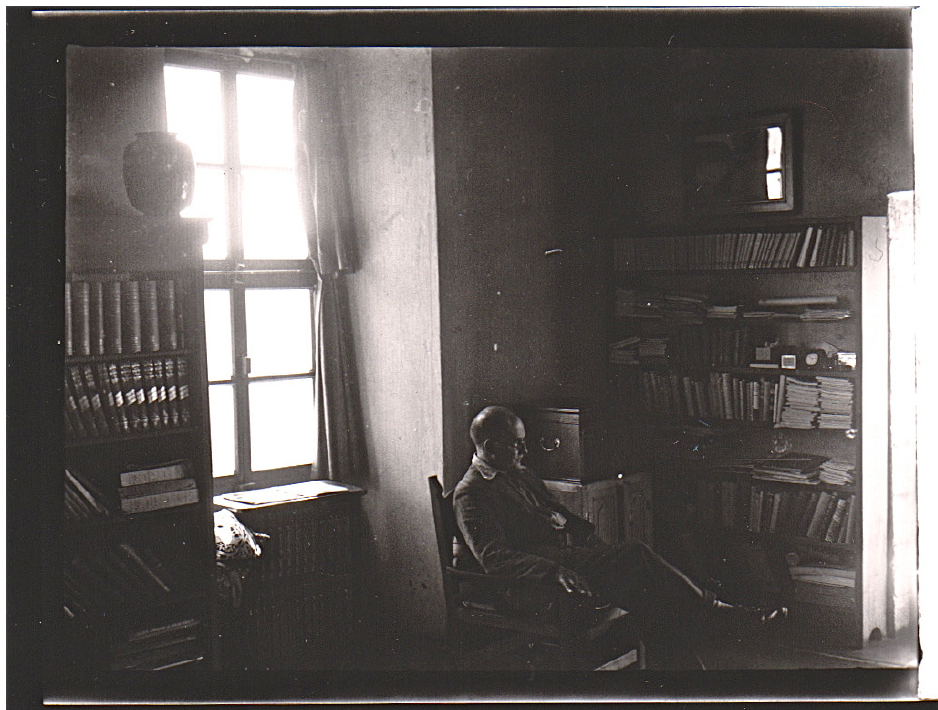
Fig. 7: George Horsfield sitting in ‘Antiquity House’, surrounded by books. (Copyright UCL Institute of